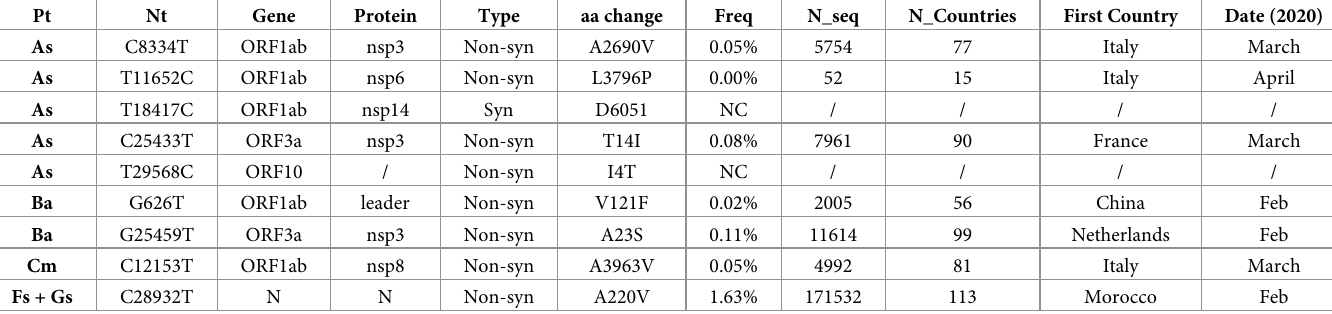
Table 4. Highlights on the results of the sequence alignment with those retrieved in the GISAID